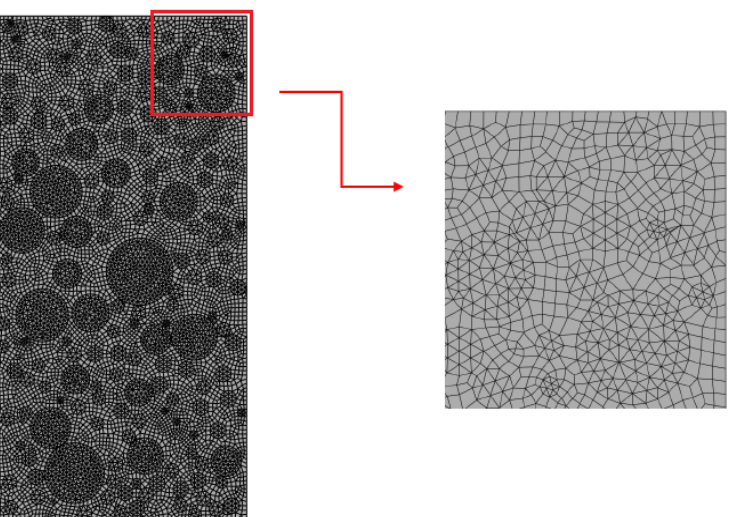
Figure 4. Mesh adopted to discretize the model.